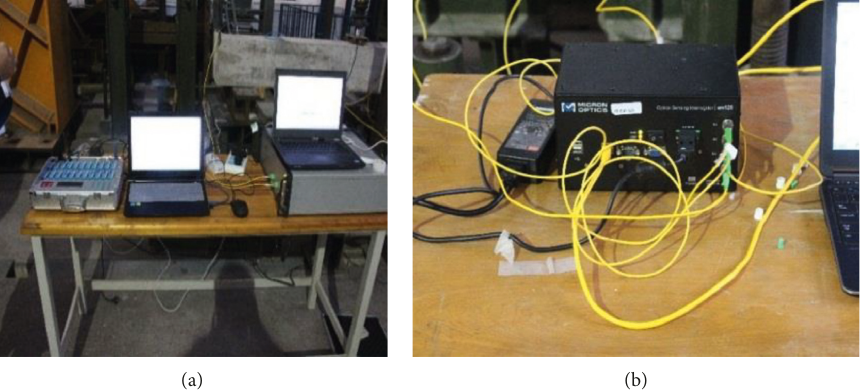
Figure 7: Data acquisition instruments. (a) BOFDA device. (b) SM-125 demodulator.